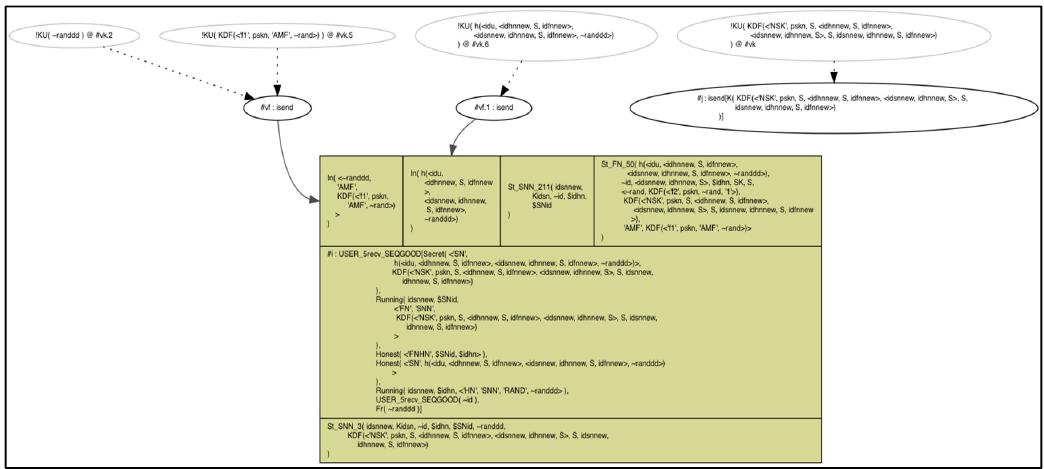
Figure 14. Secrecy of the scheme parameters during transmission on the public channel by HN . Sensors 2020 , 20 , x FOR PEER REVIEW